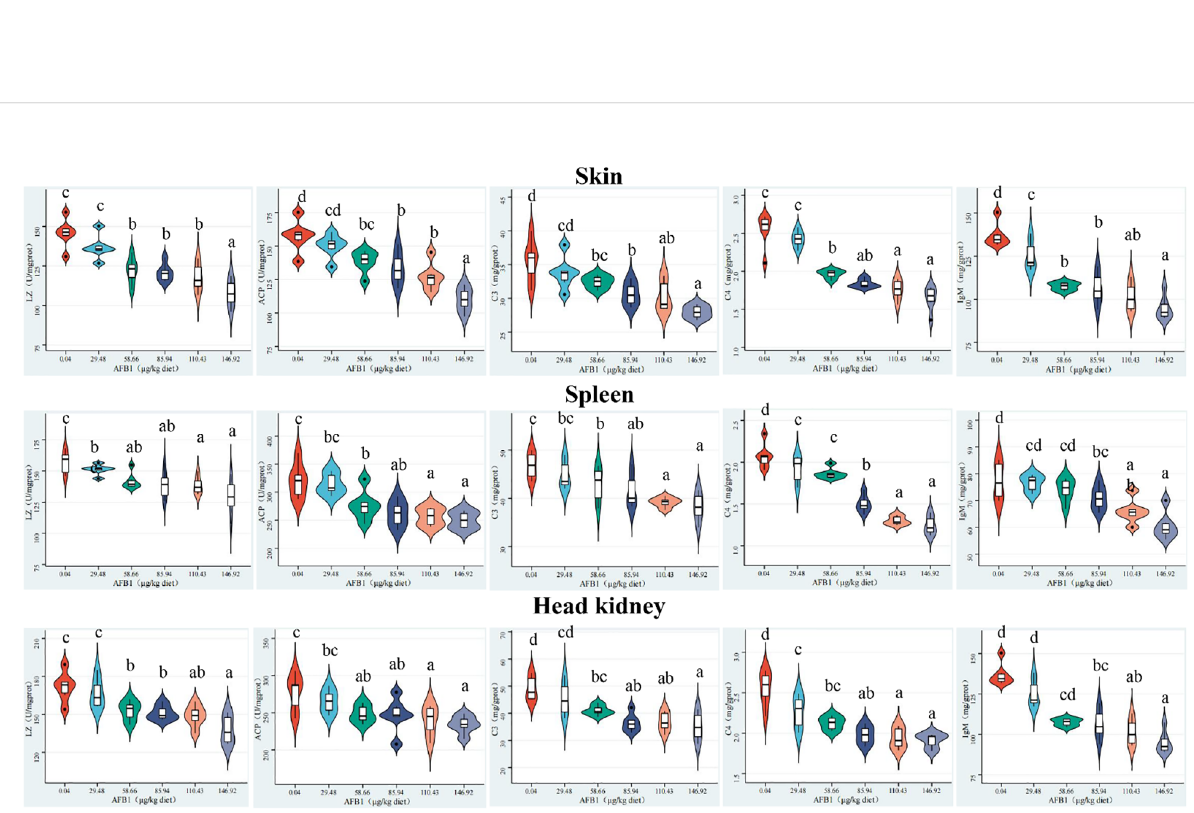
FIGURE 2 Effects of dietary AFB1 ( m g/kg) on the immune parameters (LZ, ACP, C3, C4, IgM) of skin, spleen, and head kidney of grass carp after challenged with A. hydrophila . n=6 (six fi sh in each group). Different letters represent a signi fi cance difference (P <